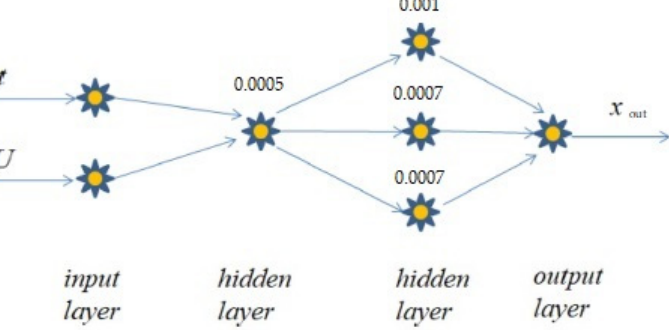
Figure 11. Neural network with one neuron in the first and three neurons in second hidden layer. Table 3. Network Table 3. Network error.